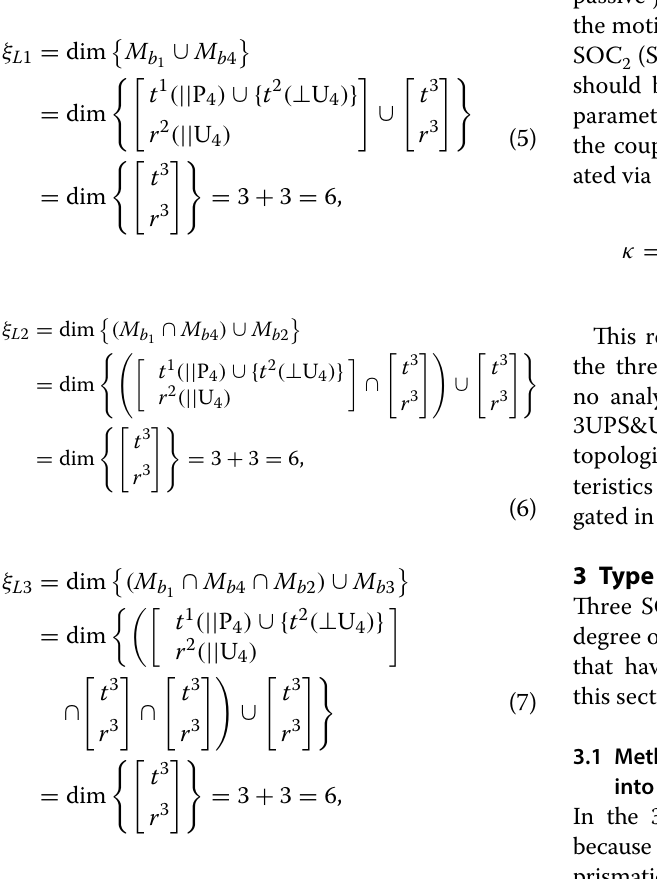
number of independent displacement equations of the three loops can be computed following the method pre- sented in Ref. [28].